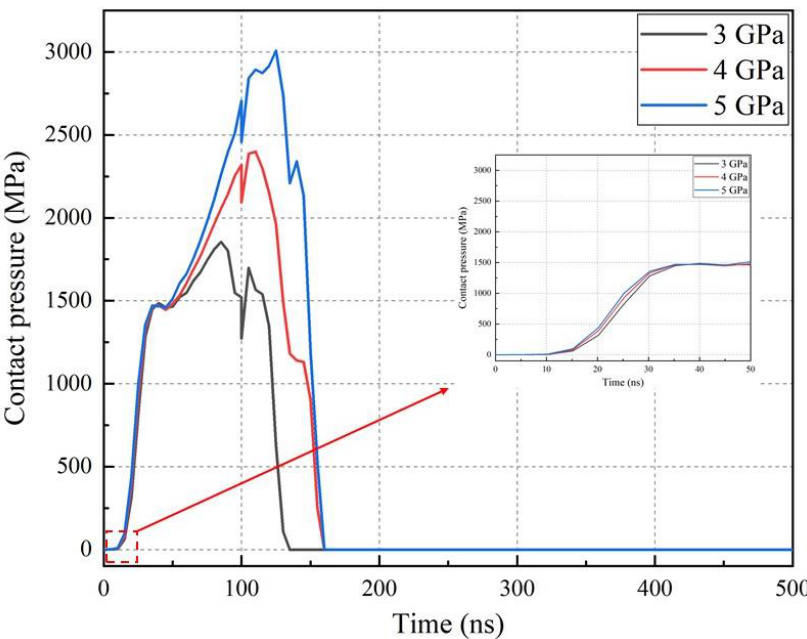
Figure 6. Contact pressure evolution of the embossment bottom at different peak pressures.